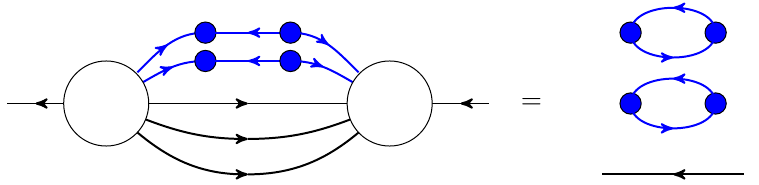
Figure 12. The identity used to show a cut containing one interior leg which is blue in 11a is isometric up to a normalization factor. This identity is easily derived from that in figure 13.